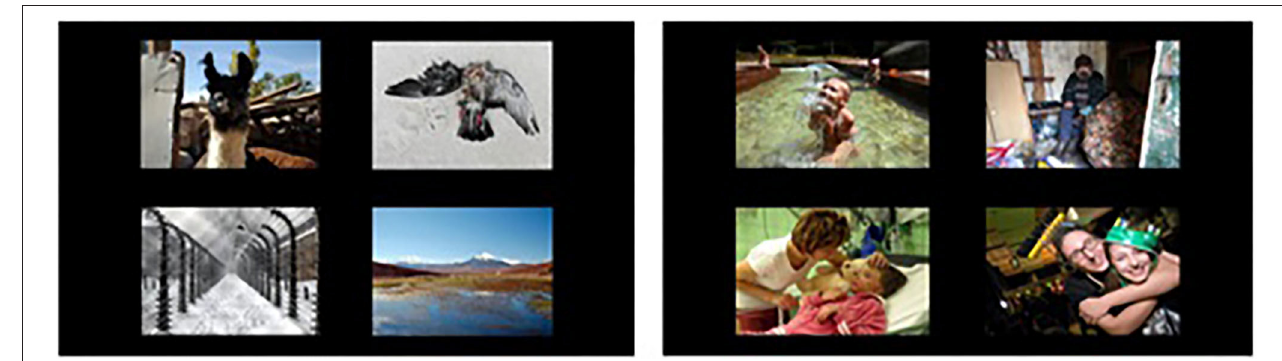
FIGURE 1 | Left: an example slide from the non-social block; Right: an example slide from the social block. All stimuli in this study, including the ones depicted in these example slides, have been obtained from two public databases, namely, the Nencki Affective Picture System (47) and the International Affective Picture System (46).